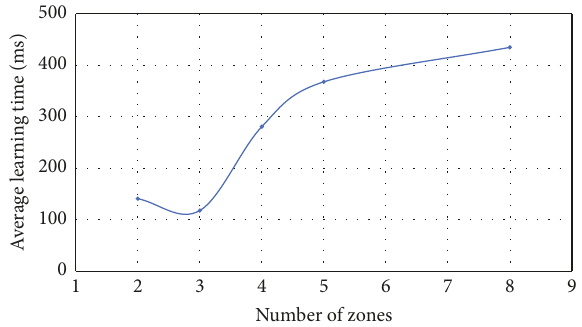
Figure 20: Average learning time of one GP model for different buildings with different numbers of zones.